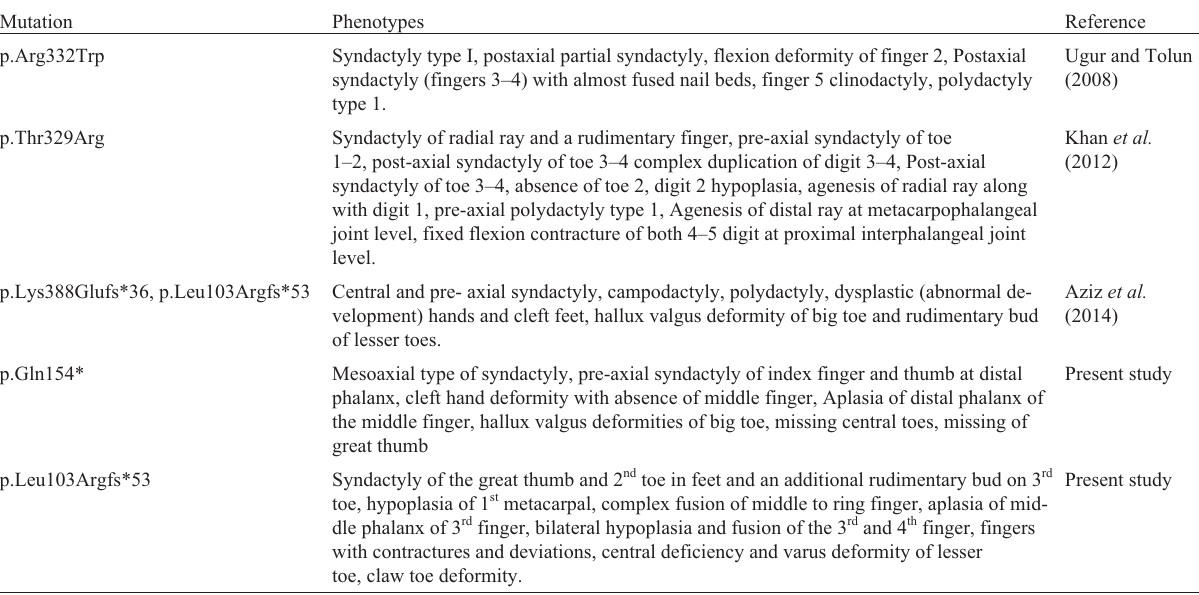
Table 1 - Comparison of the clinical features, due to sequence variants in the WNT10B gene, observed in participants of the present study and those re- ported previously.